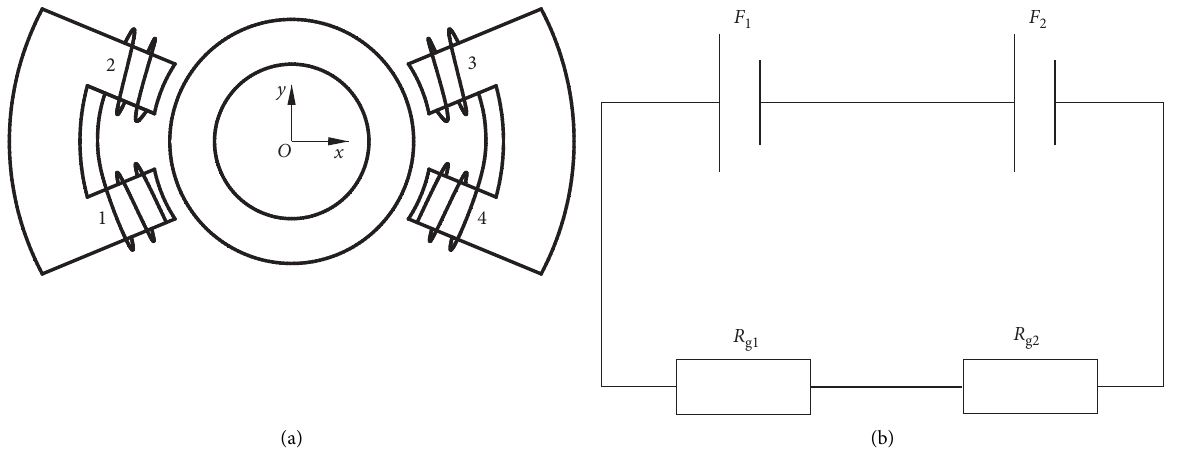
Figure 2: AMB configuration and equivalent magnetic circuit for one pole-pair. (a) AMB configuration in horizontal direction. (b) Equivalent magnetic circuit.